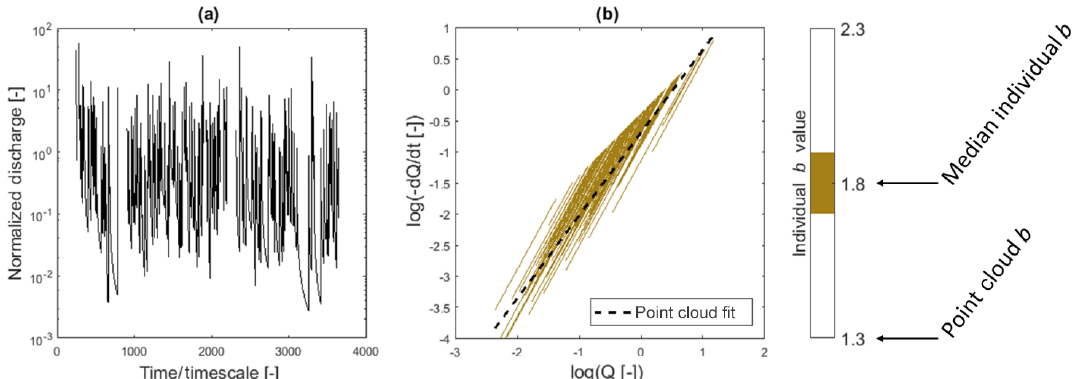
Figure 4. (a) Hydrograph with log-normally distributed event inter-arrival times and peak magnitudes with each event maintaining a constant falling-limb decay constant and (b) recession analysis with resulting parallel individual recessions having a constant b value (MI b = 1 . 8) compared to the point cloud fit (black dotted line), which results in b = 1 . 3. Discharge and time are normalized, resulting in dimensionless quantities. Gaps in the hydrograph are a result of individual event magnitudes that are smaller than the streamflow that precedes the event start. The individual recessions are offset, which when viewed collectively, results in the point cloud.